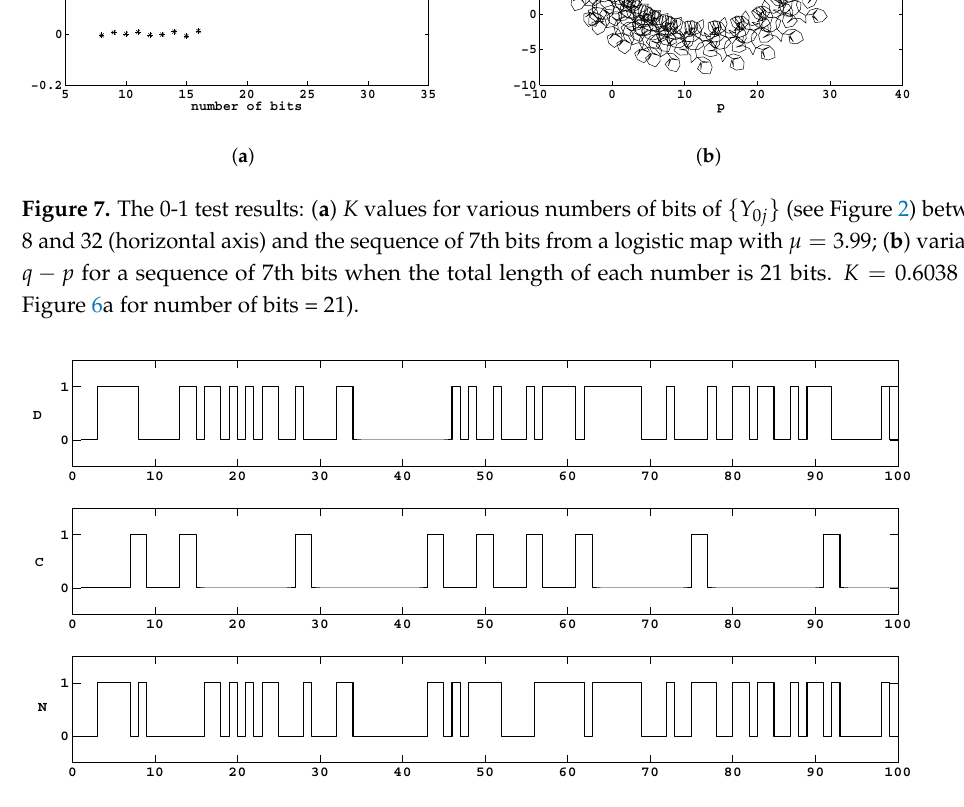
Figure 8. Sequences { D i } , { C j } and { N k } obtained from the Chua (Matsumoto) system and logistic map with µ = 3.99. The first 100 bits are shown from each sequence of 5000 bits.